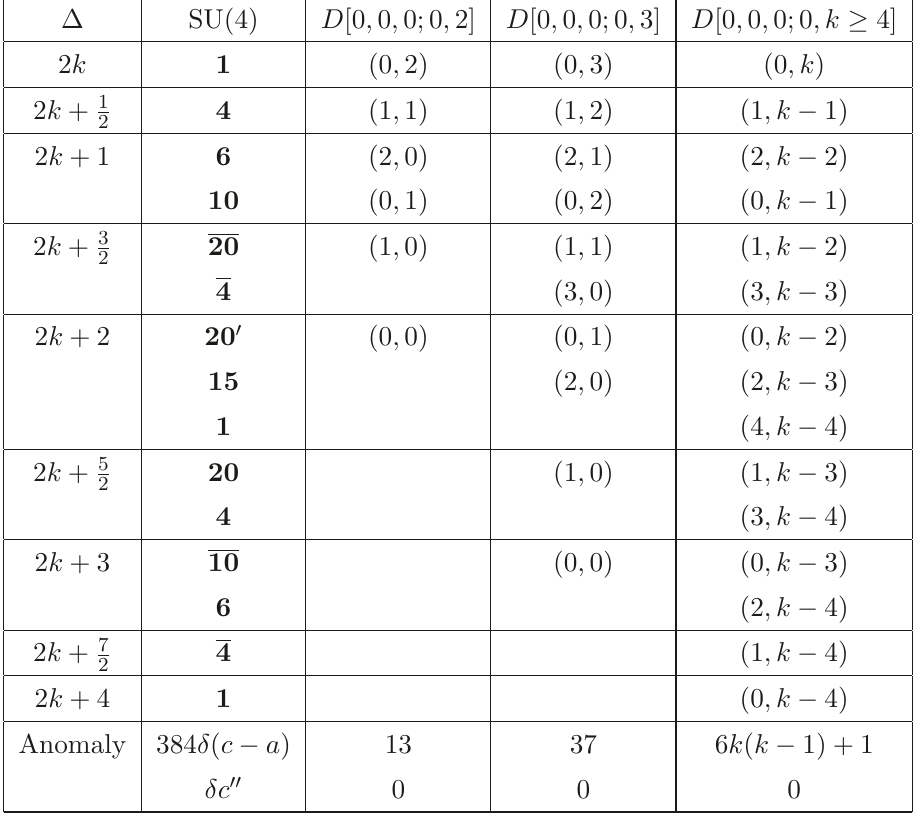
Table 4 . The N = (2 , 0) 1/2-BPS (maximum spin two) representation D [0 , 0 , 0; 0 , k ] and corre- sponding holographic Weyl anomaly coefficients δ ( c − a ) and δc ′′ . Entries are Sp(4) R representations specified by Dynkin labels ( k 1 , k 2